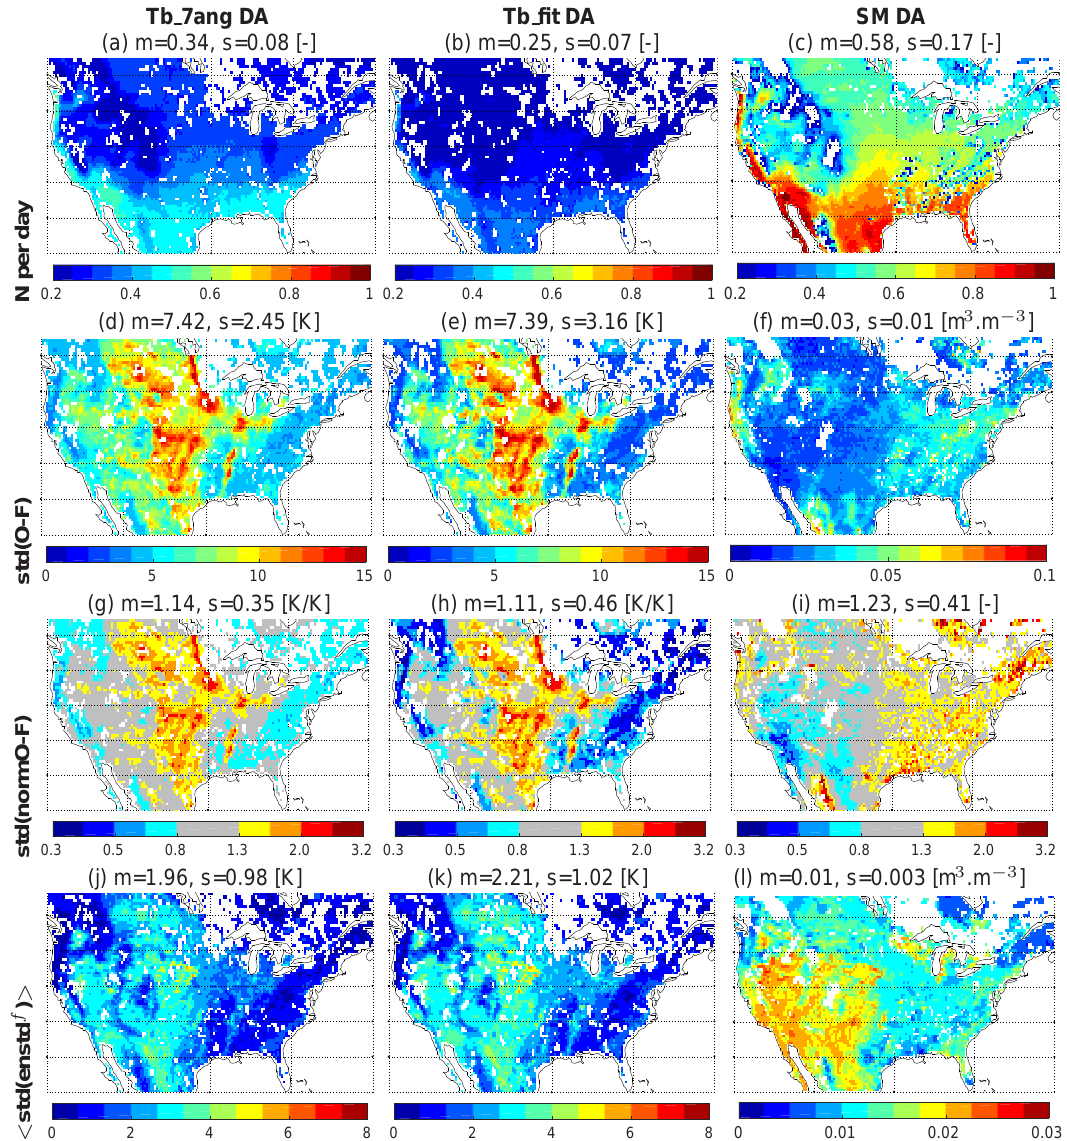
Figure 4. Observation-space assimilation diagnostics for the period from 1 July 2010 to 1 May 2015. Number of assimilated observation sets for (a) Tb_7ang assimilation, (b) Tb_fit assimilation, and (c) SM retrieval assimilation. Standard deviation of the (d) Tb innovations from Tb_7ang assimilation, (e) Tb innovations from Tb_fit assimilation, and (f) SM innovations from SM retrieval assimilation. ( g , h , i ) Same as ( d , e , f ), but for normalized innovations (normO–F). Ensemble standard deviation of the (j) Tb forecast error for Tb_7ang assimilation, (k) Tb forecast error for Tb_fit assimilation, and (l) surface soil moisture forecast error for SM retrieval assimilation. The titles show the spatial mean (m) and standard deviation (s) across each